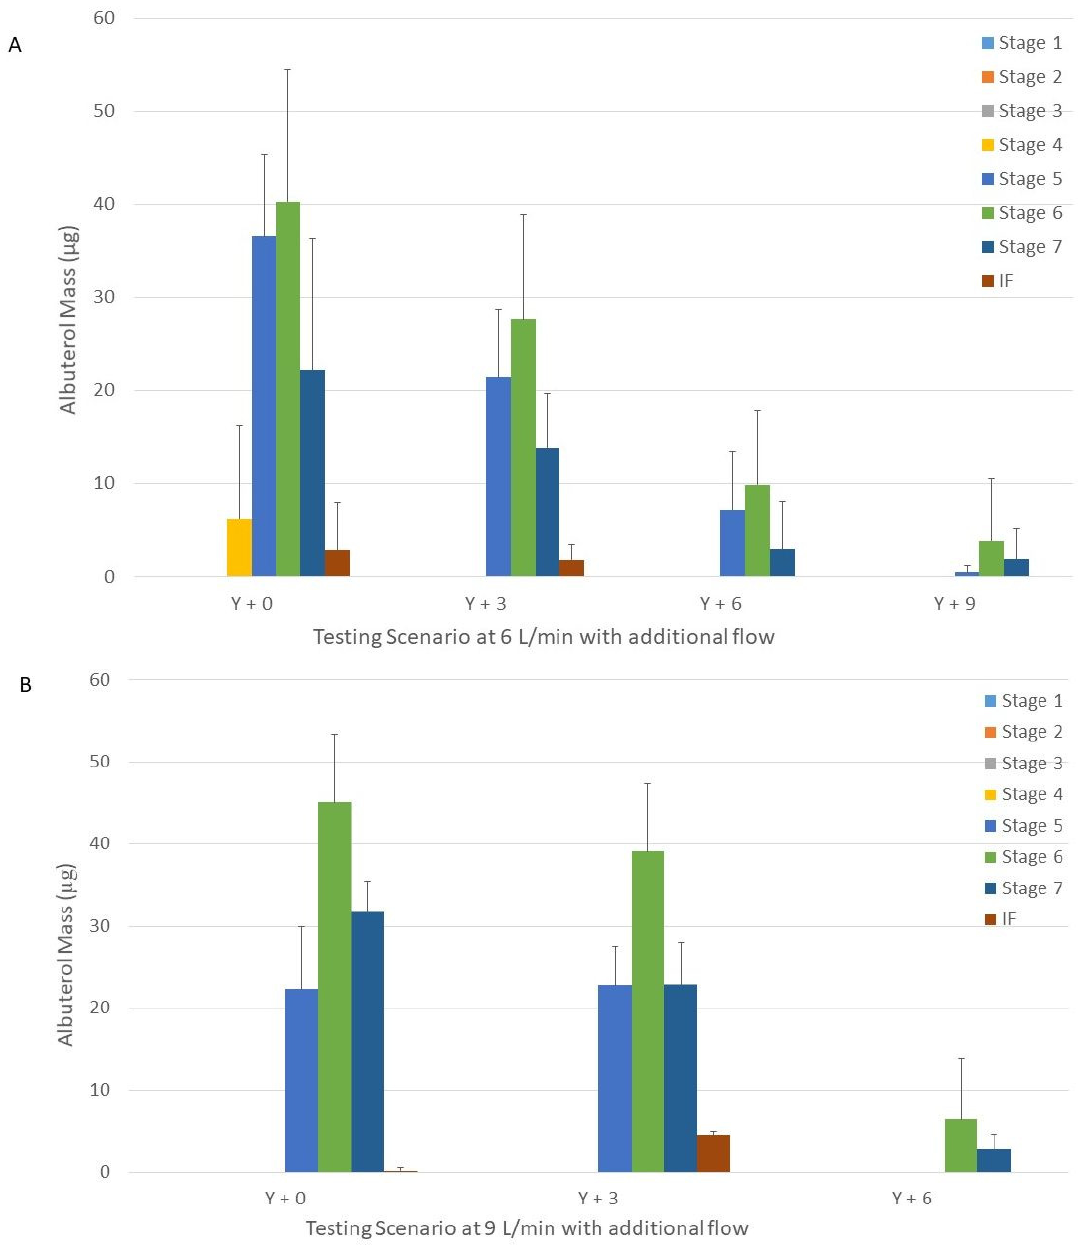
Figure 3. Drug distribution among the different stages of the Next Generation Impactor with nebulizers with Tee-piece operated at 6 (panel ( A )) and 9 L/min (panel ( B )) connected to a Y-piece connected that was to the humidifier, circuit, and large cannula with and without additional flow. Panel A = 6 L/min. Panel B = 9 L/min. Y + 0 = nebulizer with Tee-piece connected to a Y-piece that was connected to the humidifier, circuit and large cannula without additional flow. Y + 3, Y + 6, and Y + 9 were similar to Y + 0, except that they had 3, 6, and 9 L/min of additional flow, respectively provided through the Y-piece.